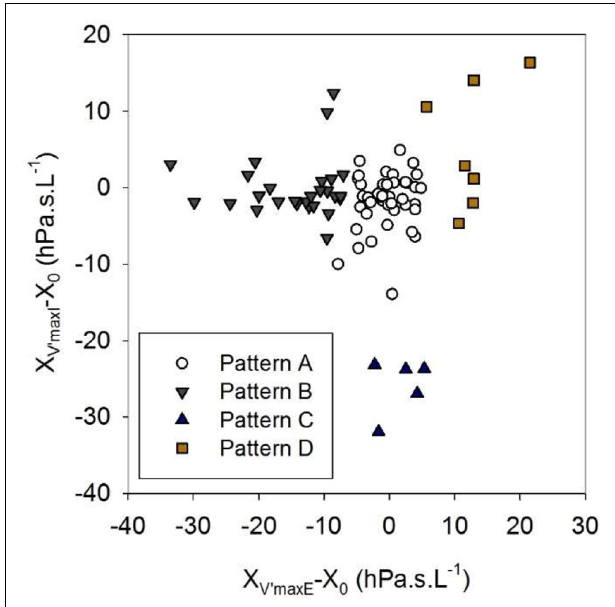
FIGURE 4 | Clusters established in the relationships between inspiratory and expiratory flow dependences of reactance. X V (cid:48) maxI and X V (cid:48) maxE are reactance values at peak inspiratory and expiratory flows, X 0 is the average zero-flow value of reactance. For definitions of Patterns A-D, see text or the legend to Table 1 .